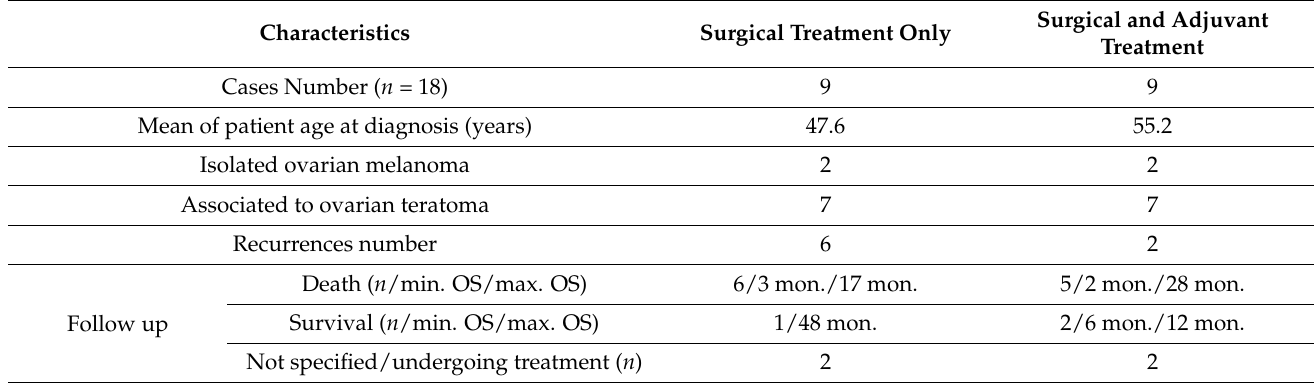
Table 3. Comparison of selected features between group treated with surgery only and group treated with surgery and adjuvant chemotherapy in primary ovarian melanoma. Characteristics Surgical Treatment Only